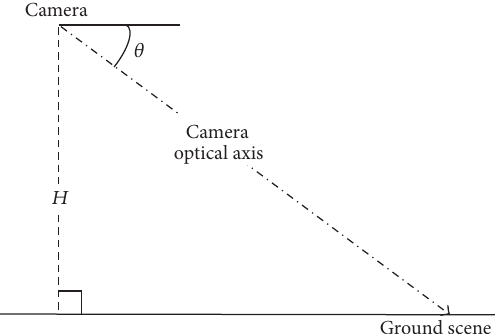
Figure 1: Defocus of focal length caused by photographic